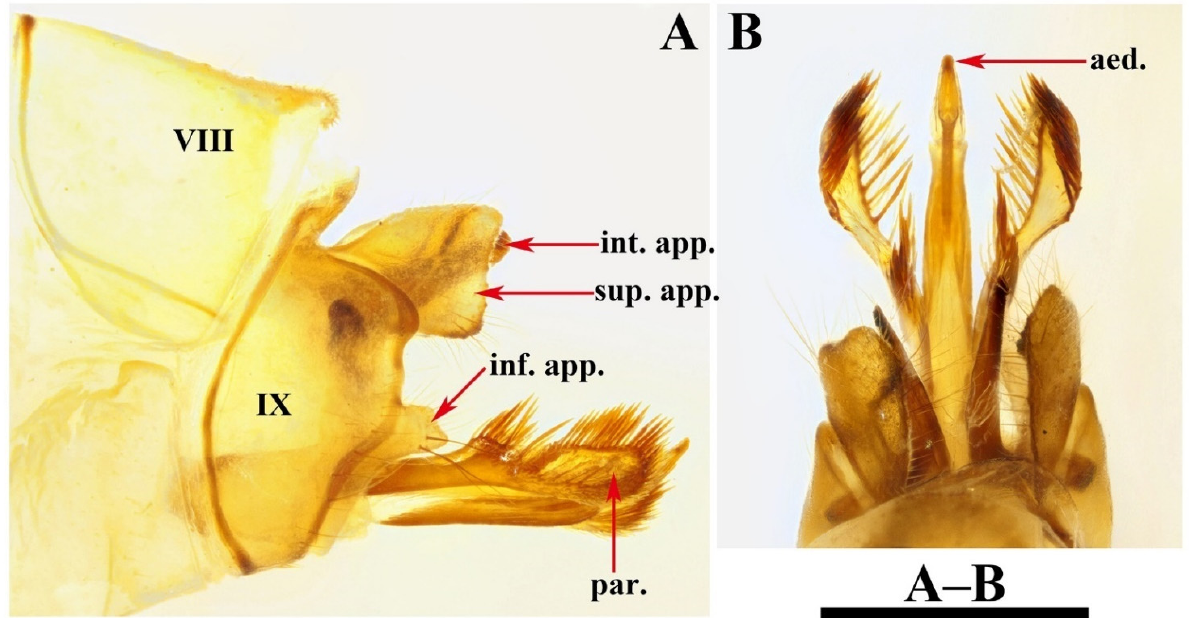
Figure 15. Limnephilus correptus , male genitalia. ( A ) Left lateral; ( B ) dorsal. Abbreviations: sup. app. = superior appendages (paired); int. app. = intermediate appendages (paired); inf. app. = inferior appendages (paired); aed. = aedeagus; par. = paramere. Scale bar: 1 mm.